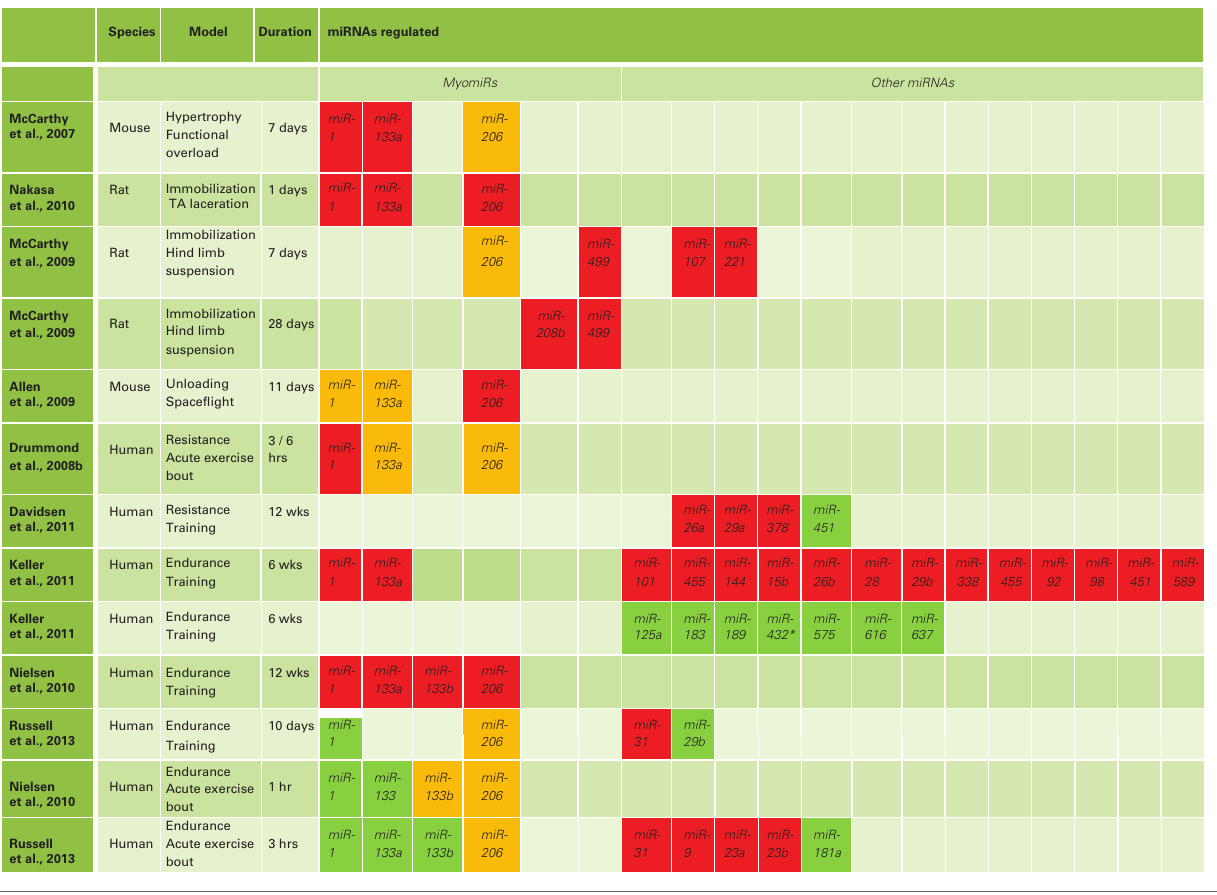
Table 1 | Regulation of miRNAs by exercise and disuse.